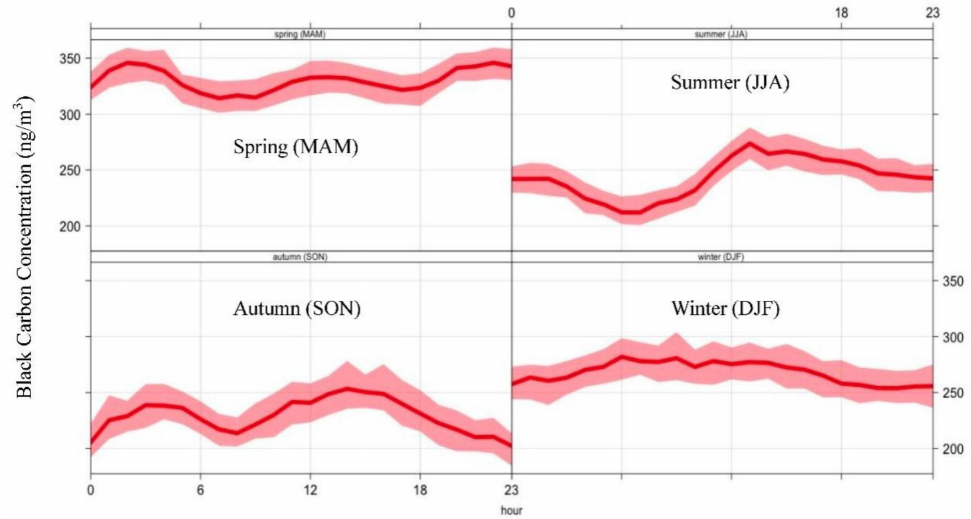
Figure 4. The daily variation of the average black carbon concentration in Mt. Waliguan over the four